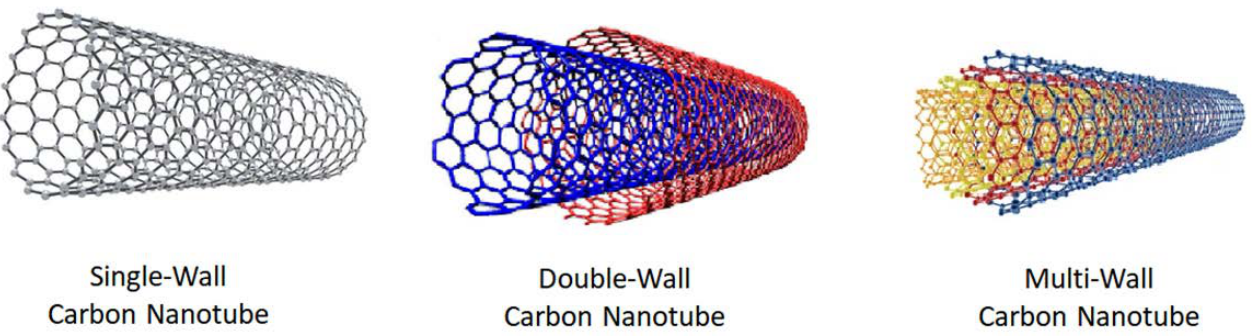
Figure 1. Types of carbon nanotubes.